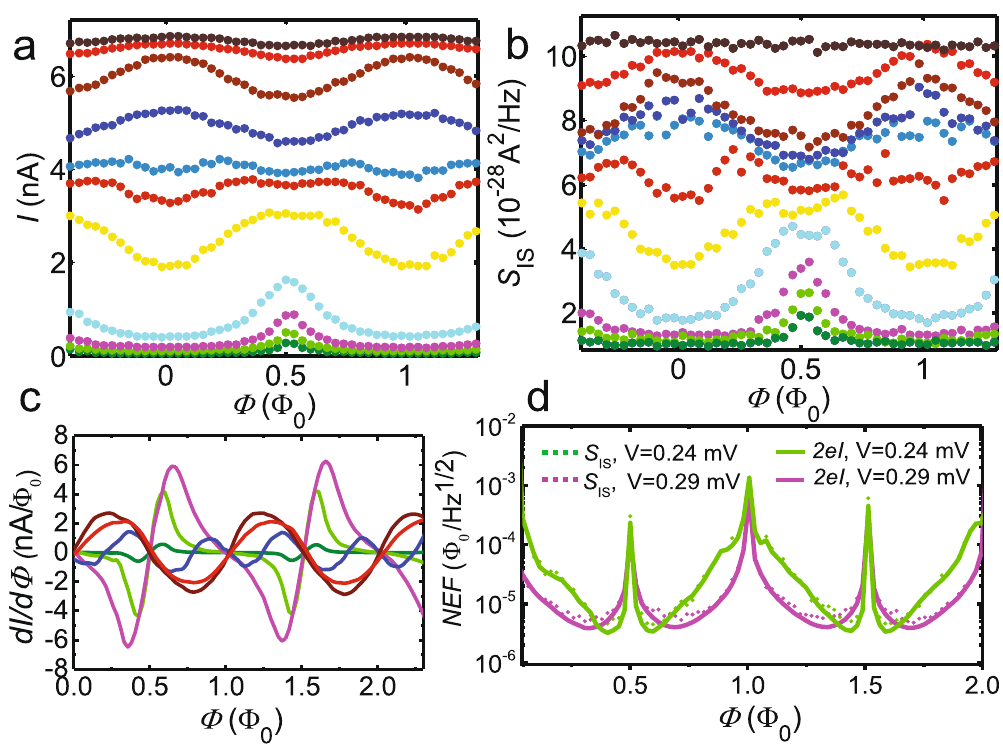
Figure 5. Characterization of flux noise performance of the voltage-biased SQUIPT device. (a) DC current and (b) , current noise as a function of magnetic flux at several values of bias voltage, measured simultaneously in the same setup at 60 mK. (c) Responsivity ∂ I / ∂Φ at several biases. (d) Flux sensitivity at the 2nd and 3rd lowest bias voltages V = 0.24 mV and 0.29 mV in panels ( a–c ). The dotted lines use S measured S V spectra, whereas the solid lines assume full shot noise = Φ S e I 2 ( ) measurement. Each color in panels (a)–(d) corresponds to a specific bias